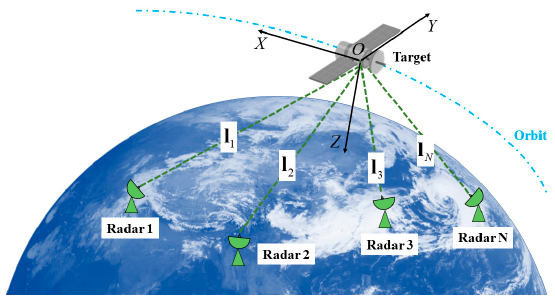
Figure 2. ISAR observation scenario based on the radar network.